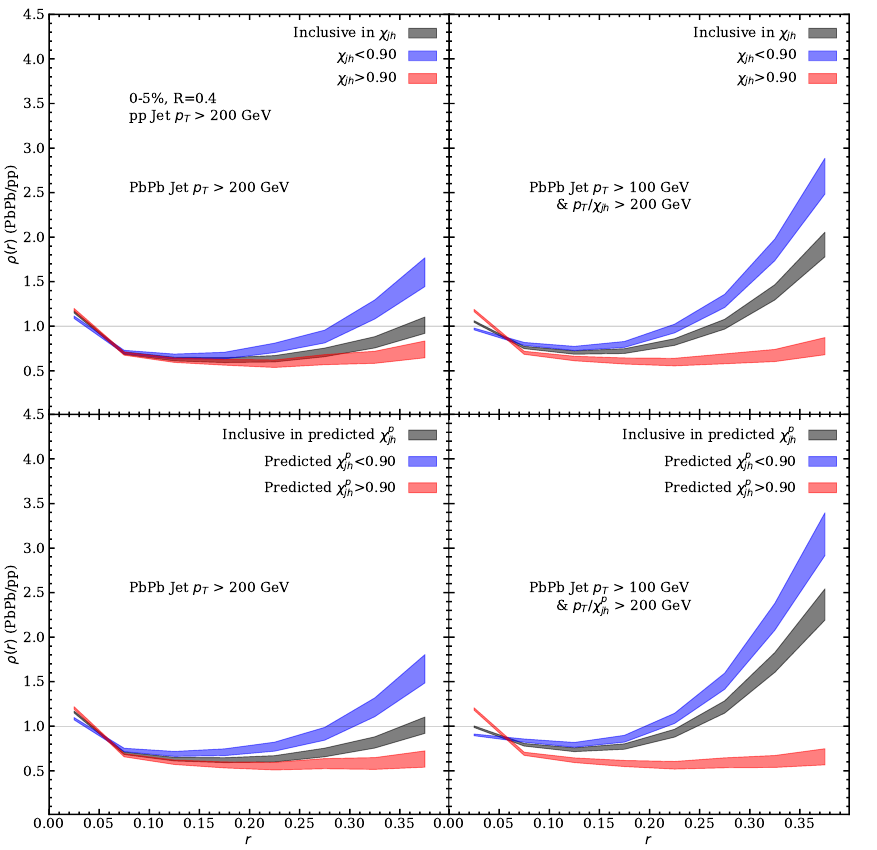
Figure 17 . Results comparing the JS ratio between PbPb and pp for the true χ jh (top row) and predicted χ p (bottom row), and the FES (left column) with the IES (right jh